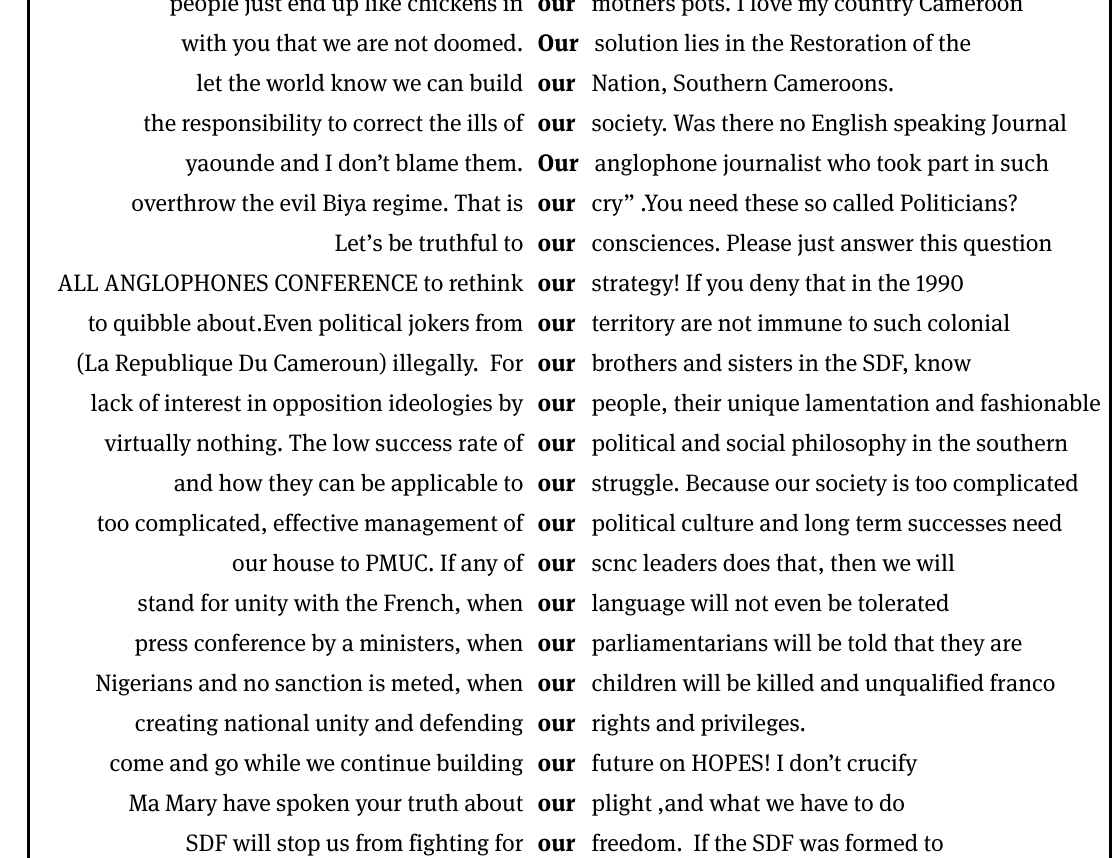
Figure 4. Sample concordance list for “our”